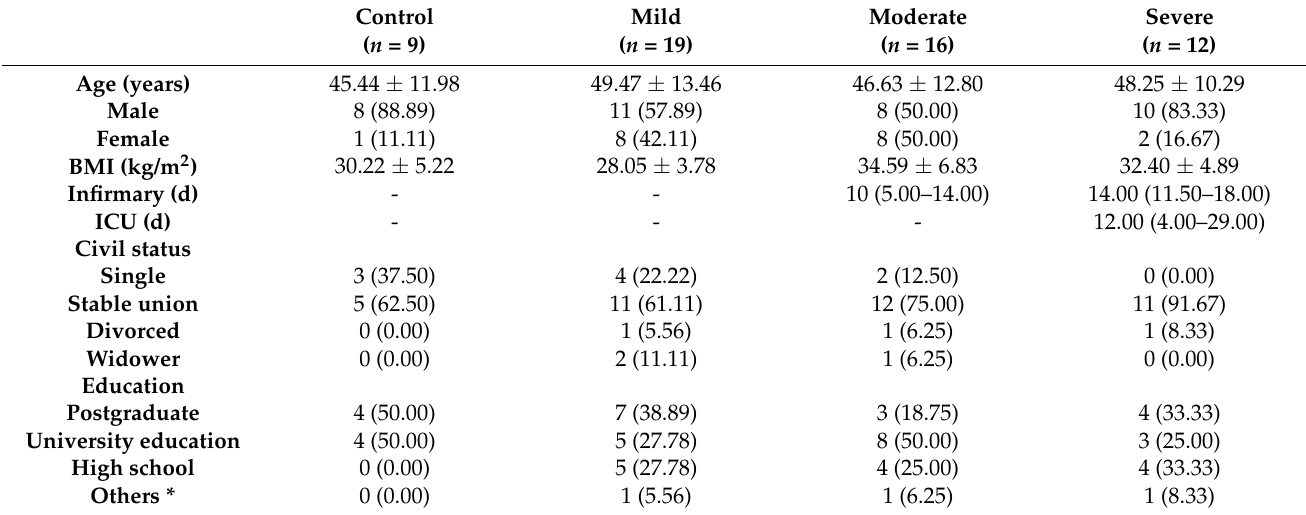
Table 1. Initial characteristics of the